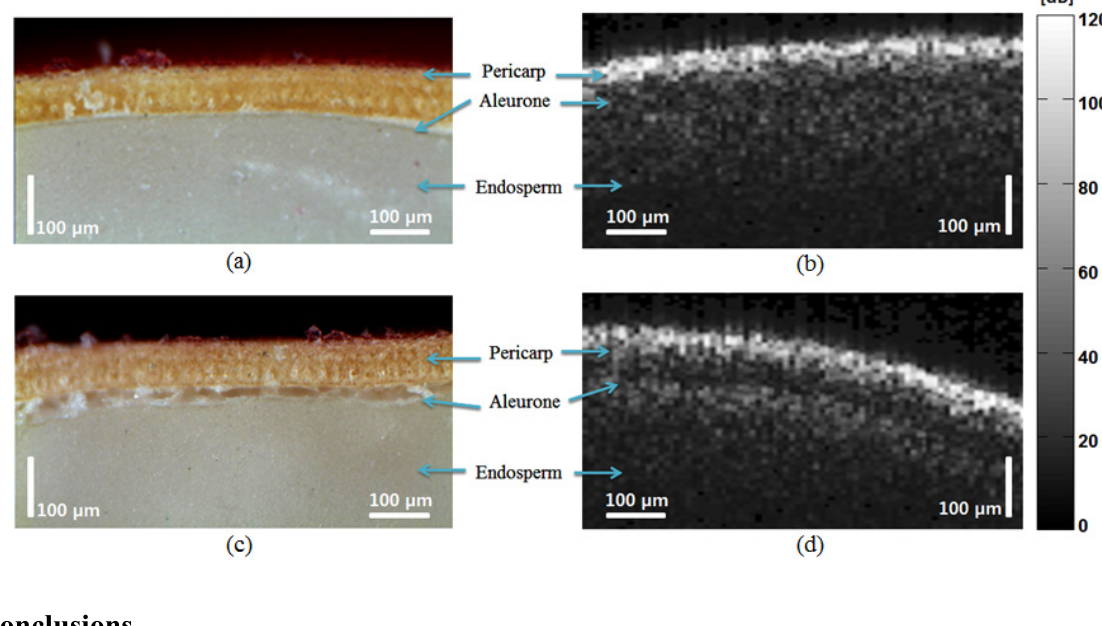
Figure 6. Comparison of OCT image and electron micrographs, ( a ) and ( c ) are an electron micrograph (500 × ) of normal and abnormal melon seeds, respectively; ( b ) and ( d ) are OCT images of normal and abnormal melon seeds,